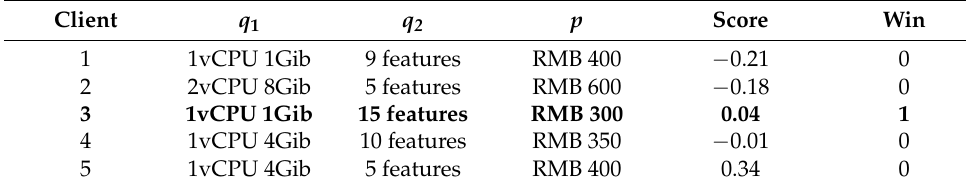
Table 2. The bth bid for federated learning.